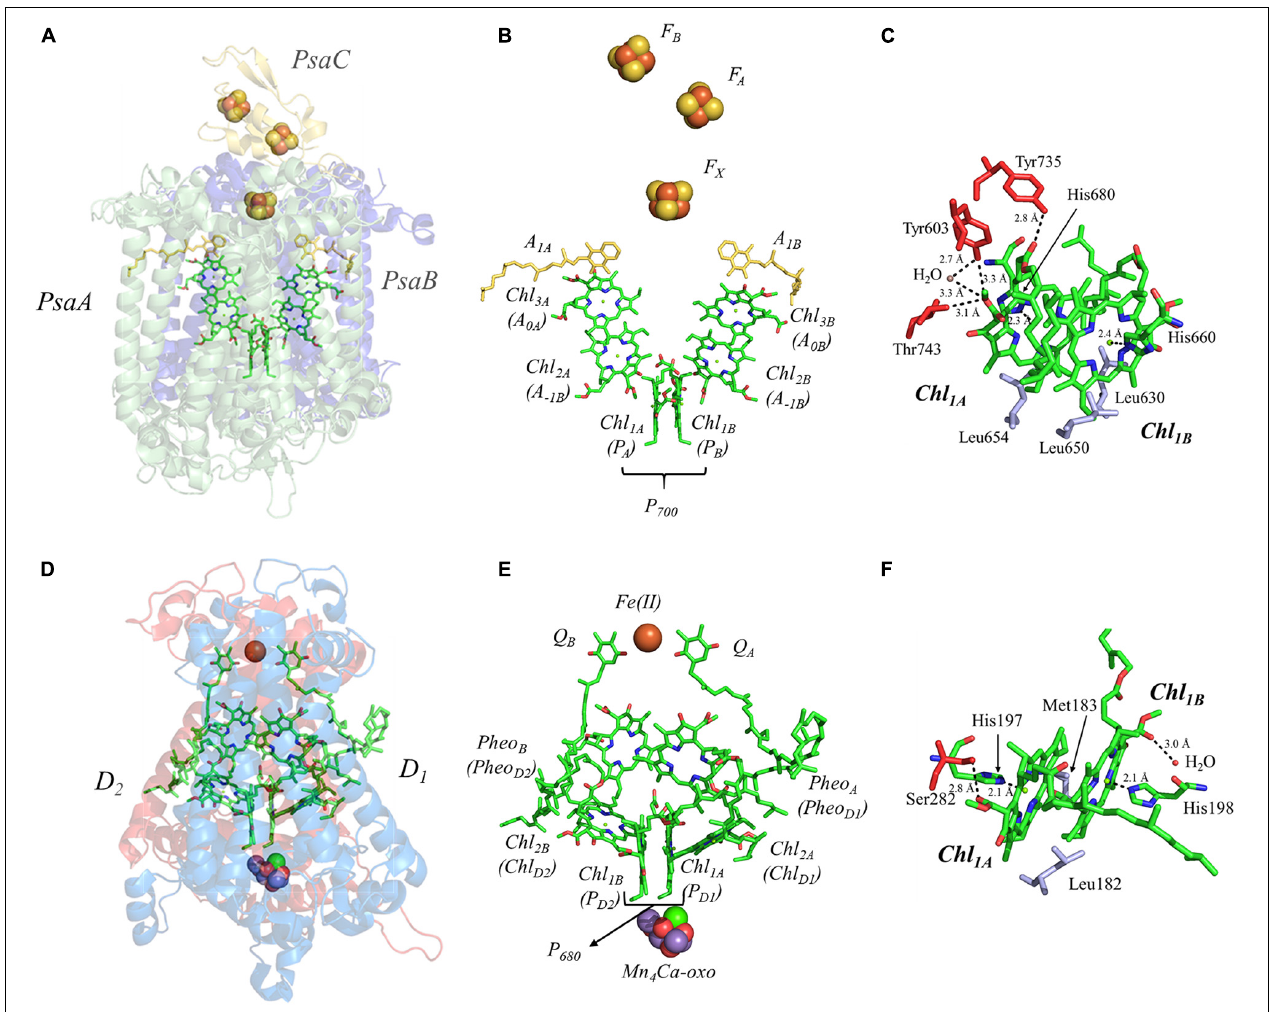
FIGURE 4 | (A) The core subunits (PsaA, green; PsaB, blue; and PsaC, yellow) and cofactors of PS I as observed by X-ray crystallography (PDB ID: 1jb0), (B) the cofactors that participate in the primary electron transfer pathway of PS I and (C) the binding pocket of the primary donor, P 700 . (D) The core subunits (D1, red; D2, blue) and cofactors of PS II as observed by X-ray crystallography (PDB ID: 3wu2), (E) the cofactors that participate in the primary electron transfer pathway of PS II and (F) the binding pocket of the primary donor, P 680 . Commonly used labels are in parentheses. Part (C,F) emphasize the prominent protein-matrix effects of the primary donor of PS I and PS II, respectively, where the residues that are hydrogen bonded to the primary donors are shown in red, and nearby non-polar or π -stacked residues are colored in